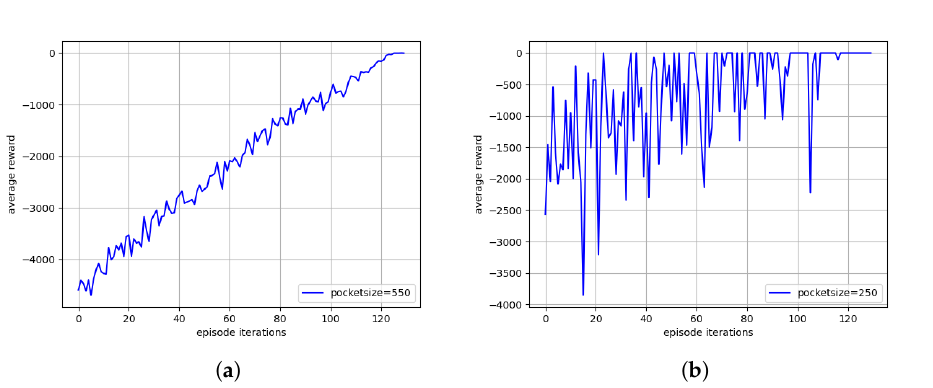
Figure 6. Convergence of LC-MARL.( a ) packet size-550; ( b ) packet size-250; Figure 7 shows the overall system rate of different traffic types with 4 SBs, where overall system rate is the sum of each BS’s UL/DL transmission rate. In the Figure, the x - axis and y -axis represents packet size and sum rate of all UEs. As shown in the Figure, compared with DDRL based framework, our proposed method can reach a higher overall system rate under all four traffic types.